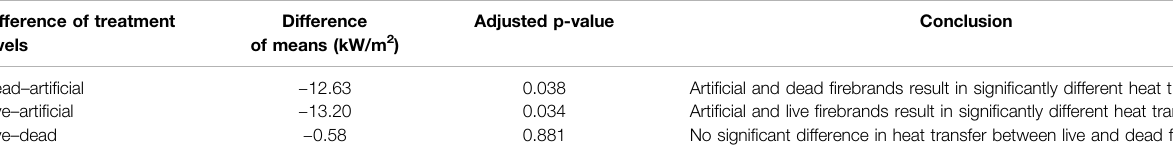
TABLE 11 | Fisher ’ s individual tests for difference of means from wood state statistical analysis. Difference of treatment levels